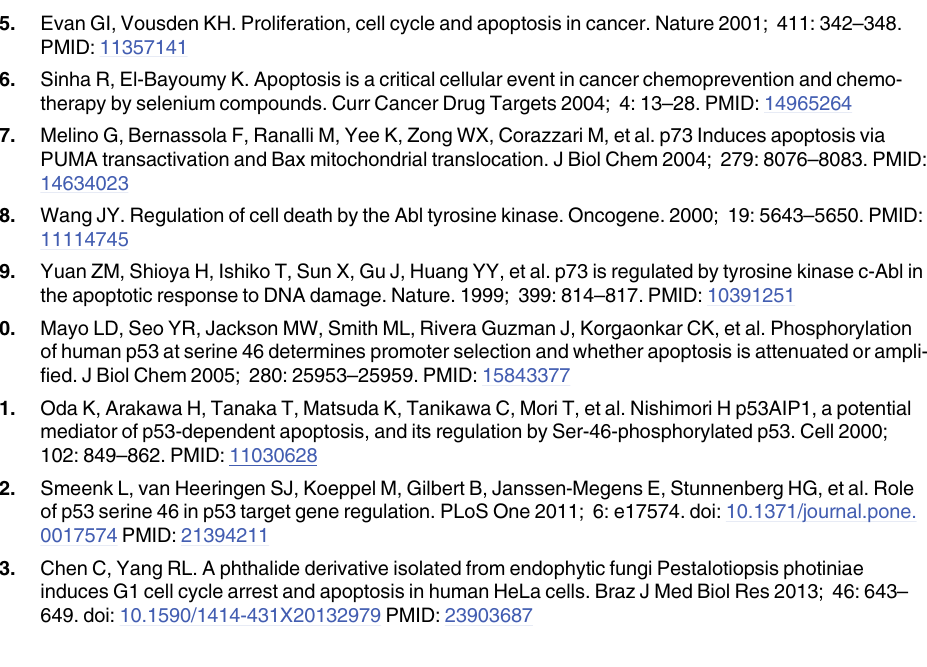
PLOS ONE | DOI:10.1371/journal.pone.0136527 August 26,